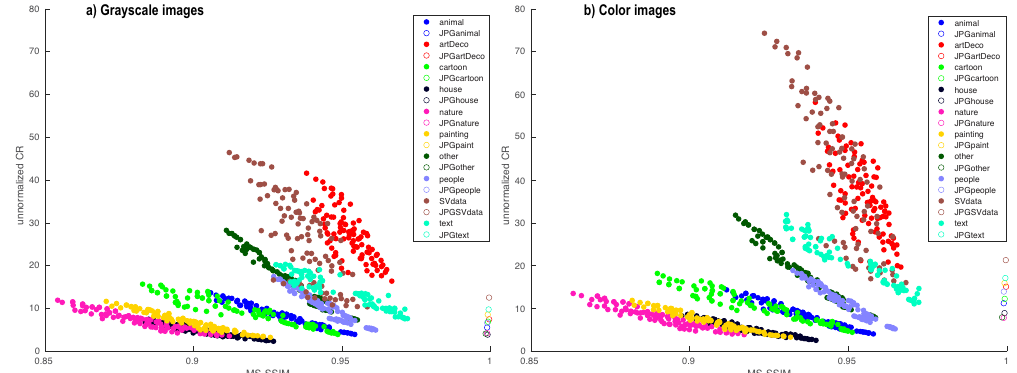
Figure 8. Average MS-SSIM vs. CR for 10 image types for CDMD (filled dots) and JPEG (hollow dots). Left shows results for the grayscale variants of the color images (shown